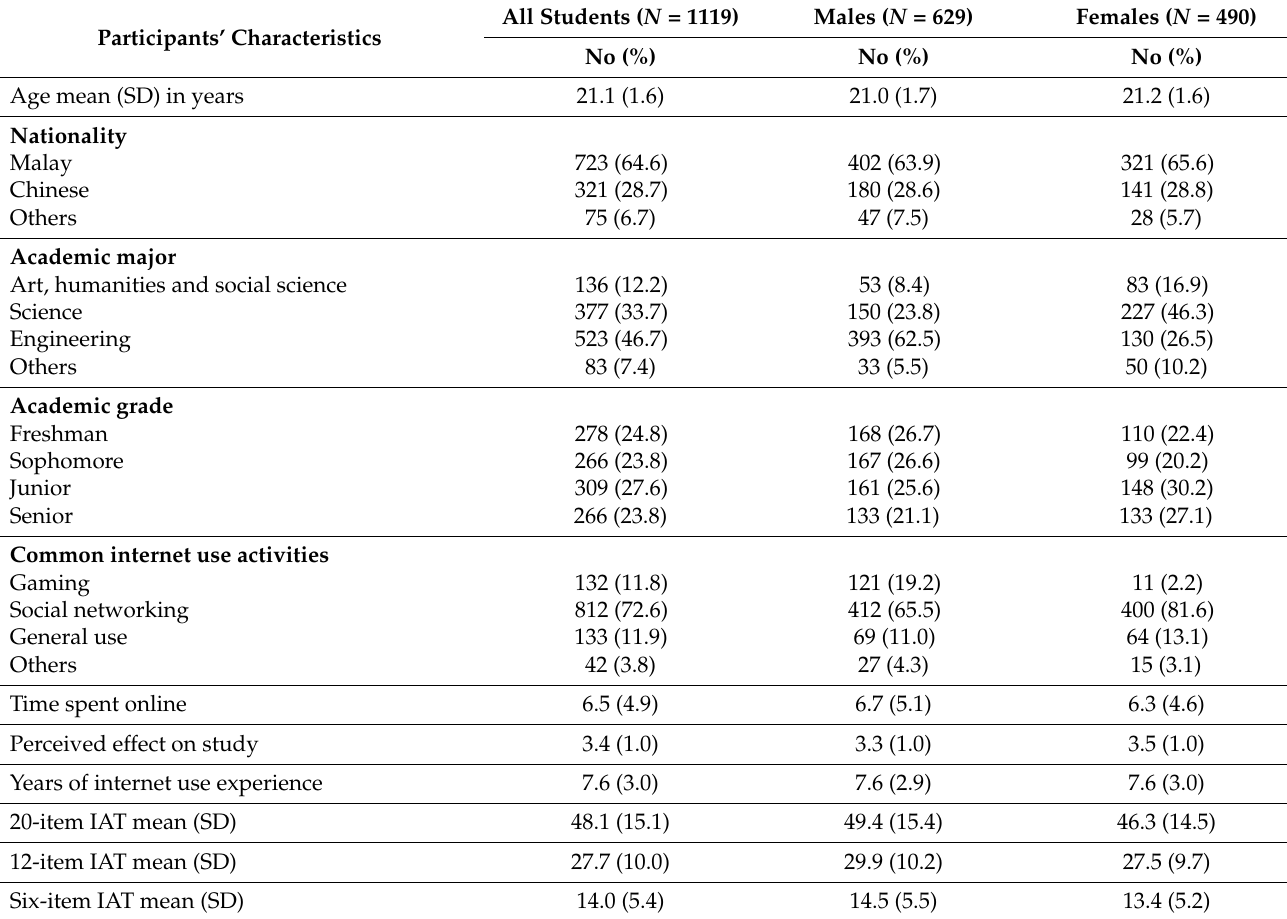
Table 2. Sociodemographic, academic, and internet use characteristics of participants in the university student sample. Participants’